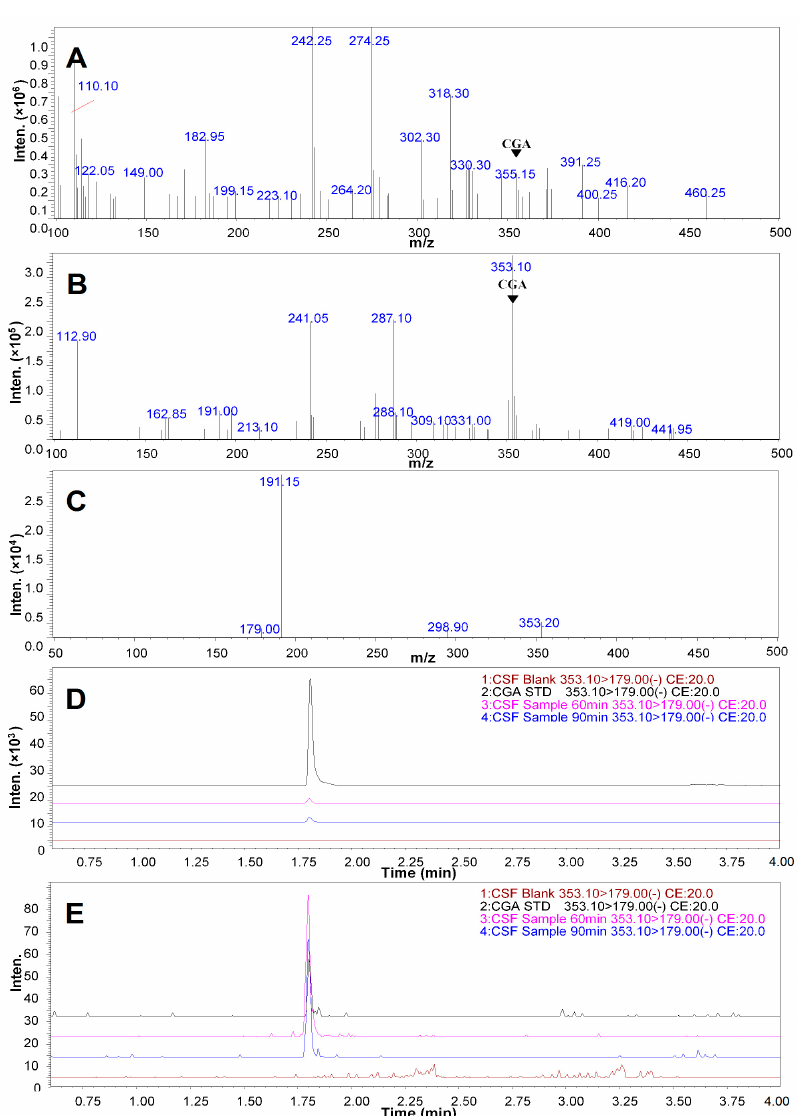
Figure 6. Analysis of CGA and CSF samples in the rats treated with water extract of E. ulmoides (EUWE) by UHPLC-ESI-MS/MS chromatogram. ( A ) Positive Scan m / z 100–500 of CGA; ( B ) Negative Scan m / z 100–500 of CGA; ( C ) MS/MS spectrum of m / z 353.10 of CGA in the negative ion mode; ( D ) MRM of channels ESI − 353.10/191.15 for CGA and CSF samples in rat treated with EUWE; ( E ) MRM of channels ESI − 353.10/179.00 for CGA and CSF samples in the rat treated with EUWE. Notes: chromatographic